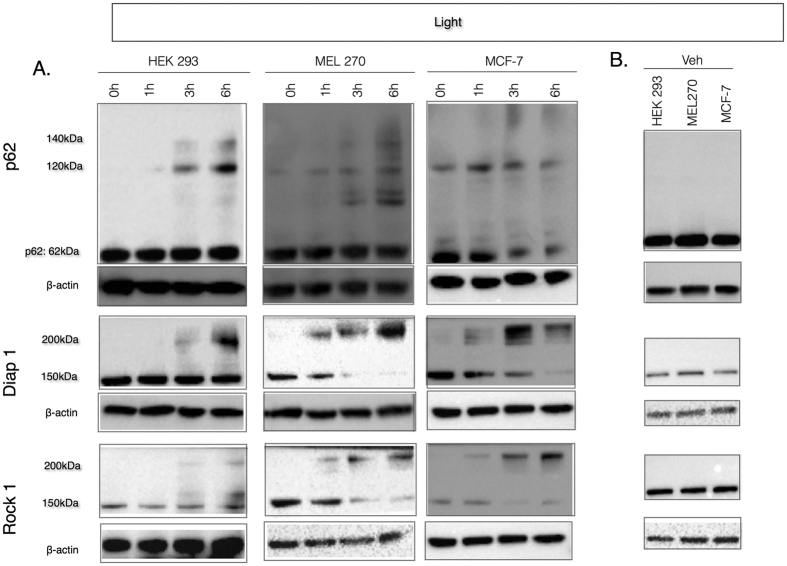
Time course of high molecular weight complexes (HMWC) formation in cellular homogenates spiked with Verteporfin.Western-blot of protein extracts from cells never exposed to VP in culture but incubated at room temperature with 7.5 μg/ml VP post lysis in ambient light (incubation and electrophoresis) for 0 h (5 min), 1 h, 3 h and 6 h. P62 dimers were noticed as early as 1 h for HEK, earlier for MEL 270 at 0 h (5 min). The same finding was observed for Diap1, Rock1 and HMWC in light as early as 1 h and in a cell dependent manner.